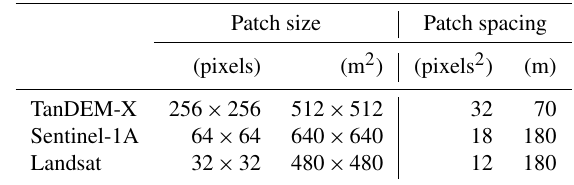
Table 2. Patch size and patch spacing used for velocity determina-